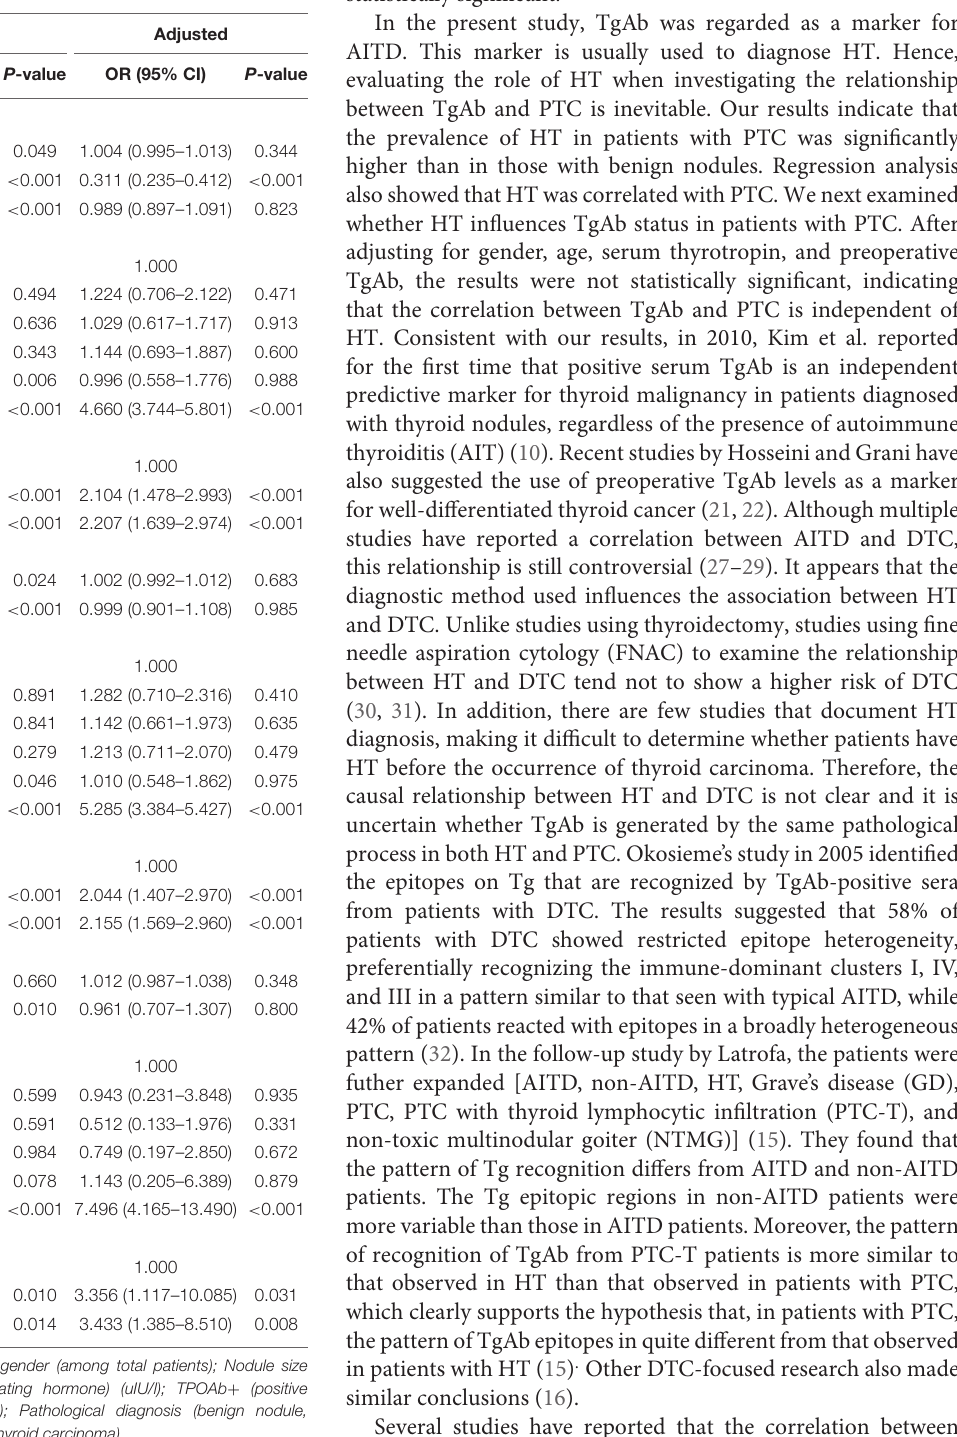
TABLE 3 | Logistic regression analysis to determine the associations between tested factors and TgAb status in different